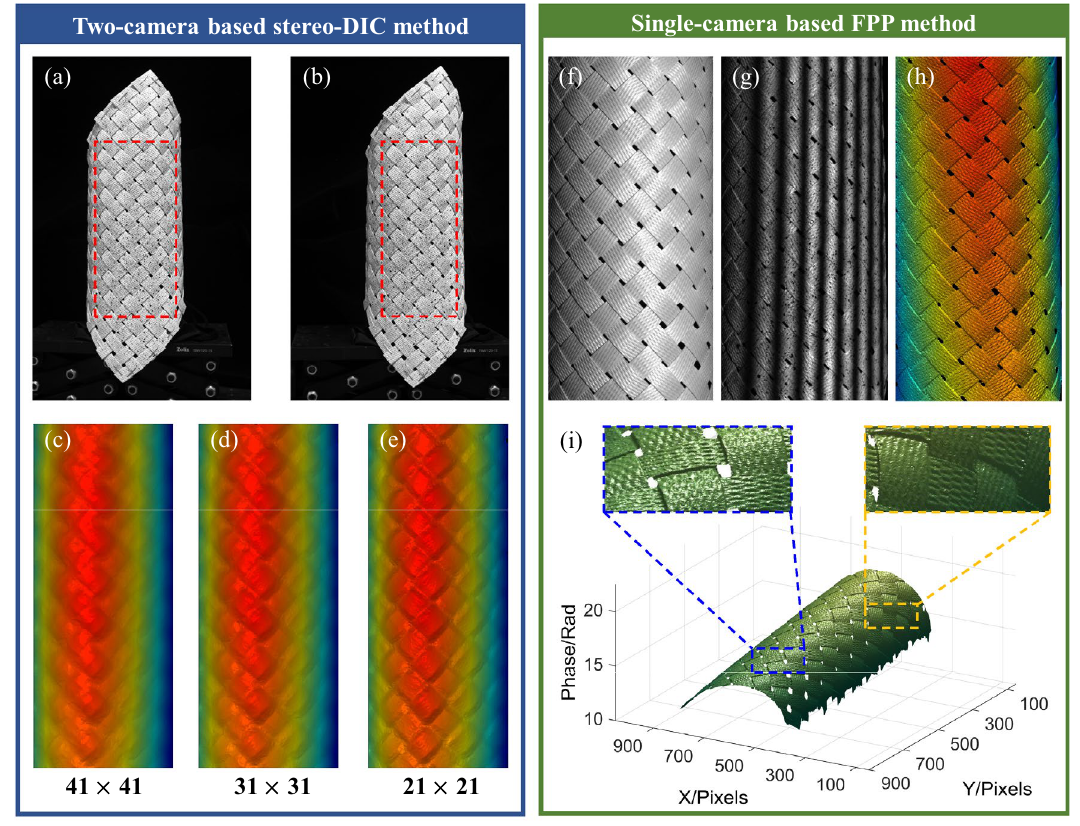
Figure 9. Comparative experiment on reconstruction of a biaxially braided tube using stereo-DIC and single- camera DIC-assisted FPP. ( a , b ) Captured images with speckle from left and right cameras in stereo-DIC. ( c – e ) Reconstructed disparity map in stereo-DIC using different subset sizes (pixel). ( f ) Texture map before spraying speckle. ( g ) Captured fringe pattern after spraying speckle. ( h , i ) Reconstructed phase maps in single-camera DIC-assisted FPP from top and oblique